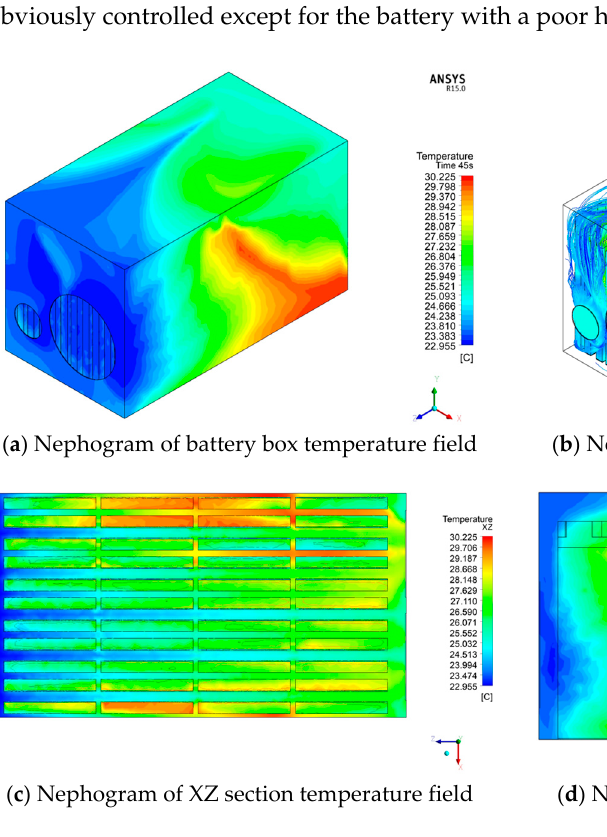
Figure 10. Distribution of discharge temperature in short time (8.9 °C discharge 45 s) with large current.